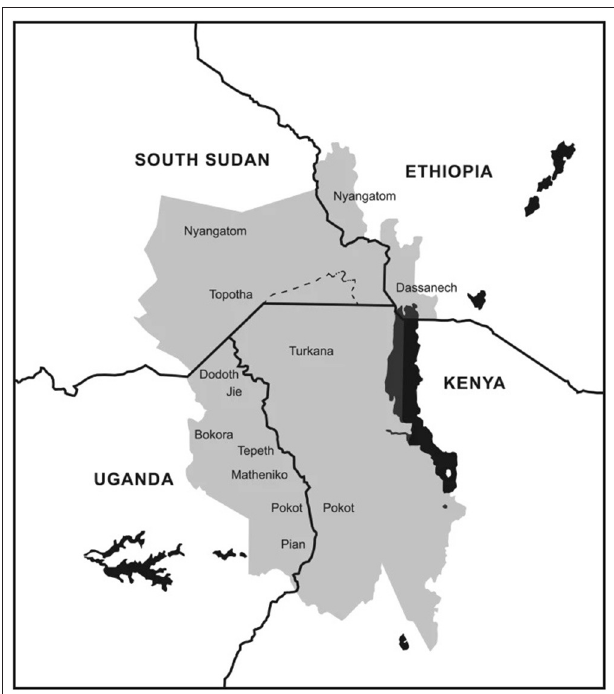
FIGURE 1 | Map of the Karamoja cluster obtained from